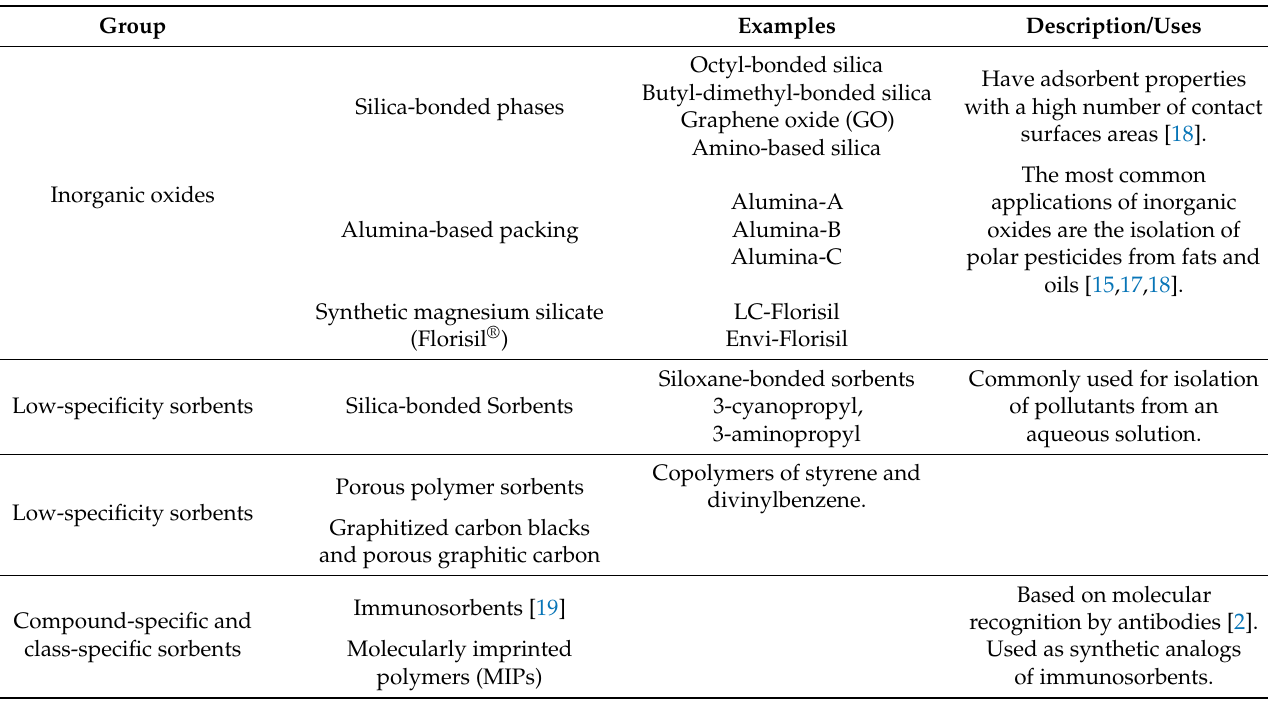
Table 2. Information on the SPE sorbents.